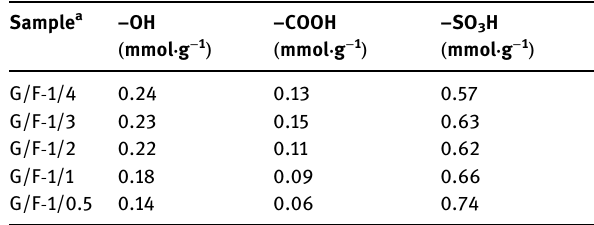
Table 2: Groups content of the prepared